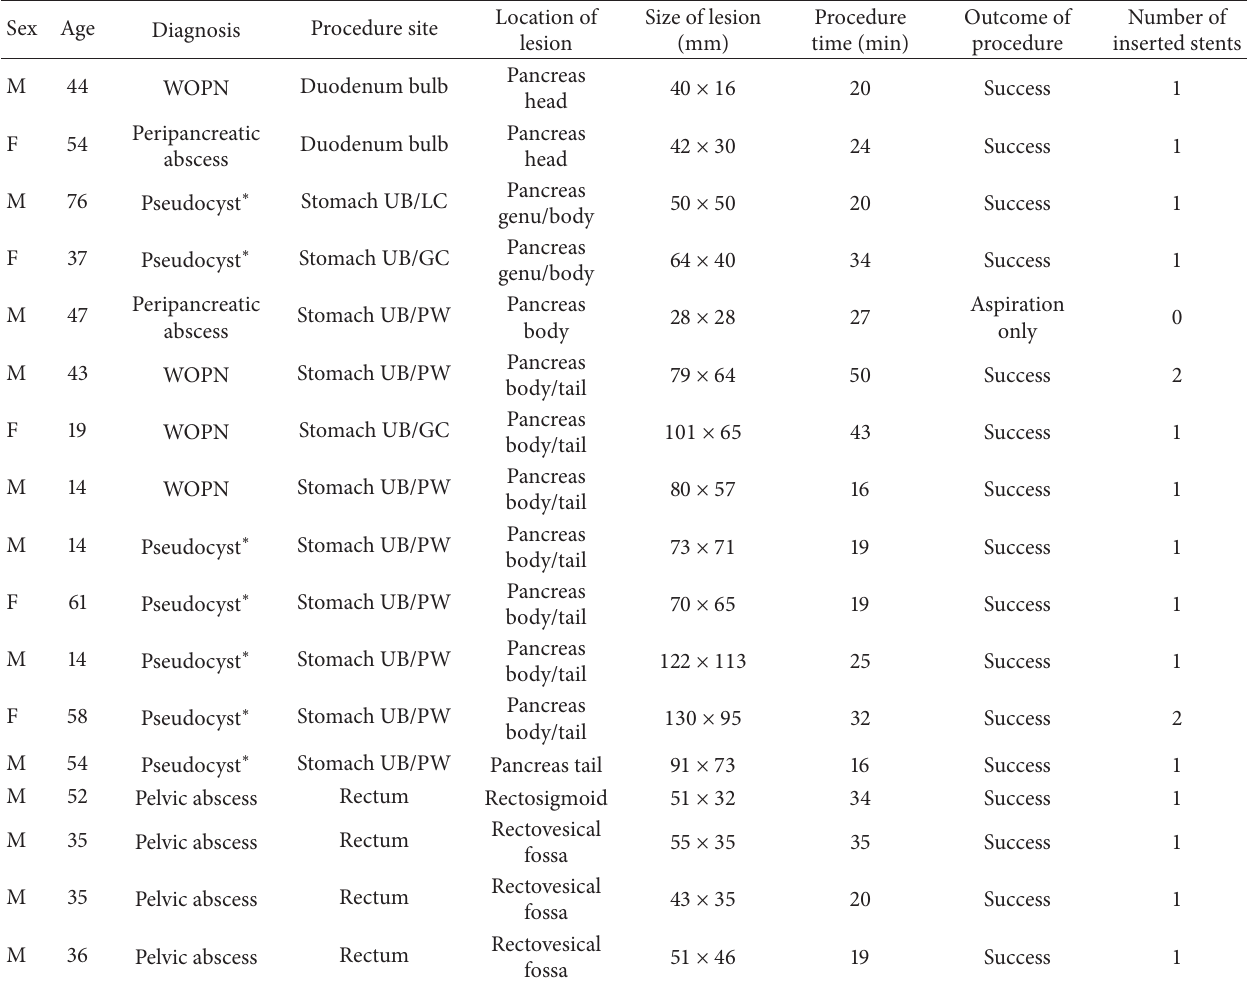
Table 1: Clinical features and outcomes of 17 procedures in patients undergoing endoscopic ultrasound-guided drainage without fluoroscopic